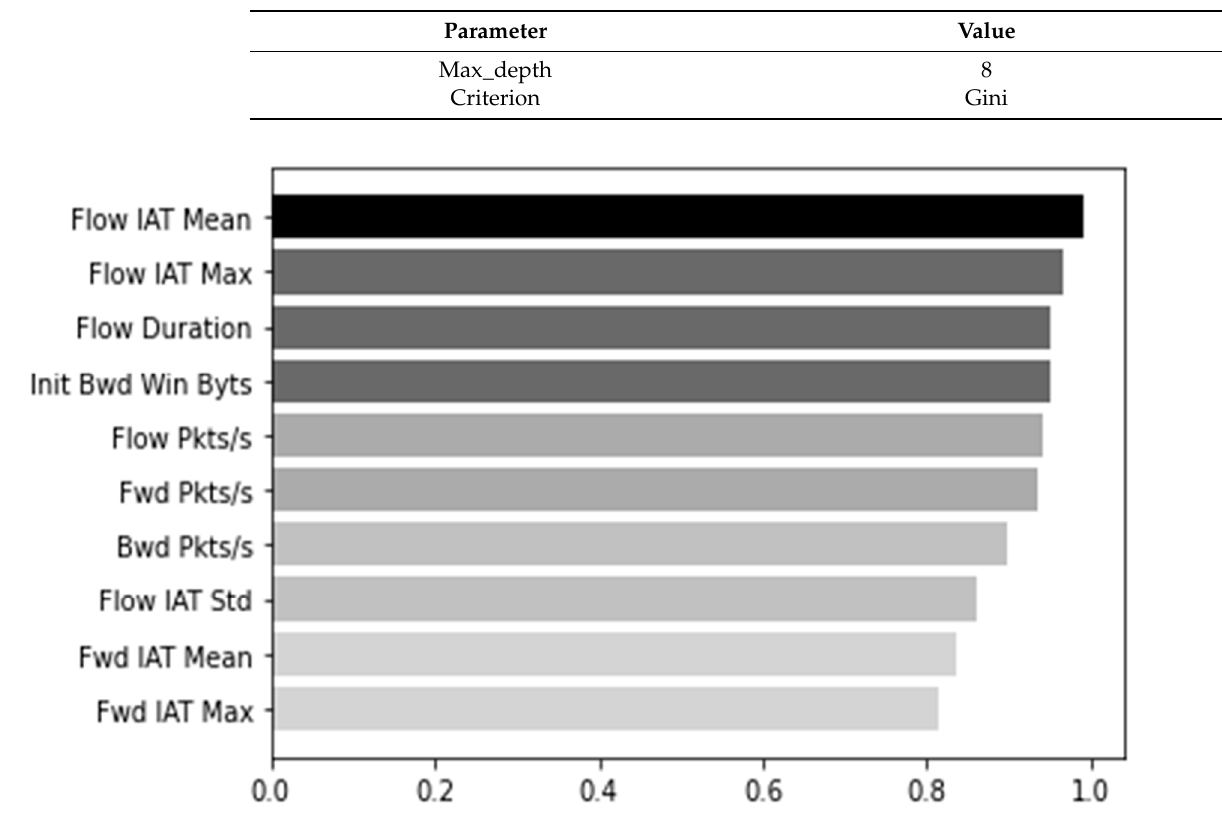
Figure 5. Top ten features based on Information Gain.